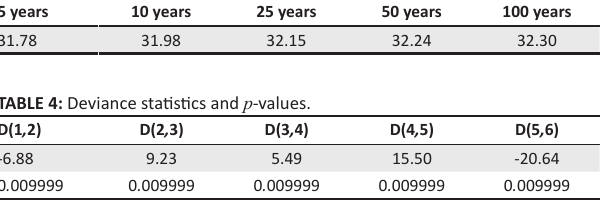
TABLE 5: Tail and quantile estimation for the generalised extreme value distribution for annual maxima with r = 4. Quantiles Temperatures (°C) ( x